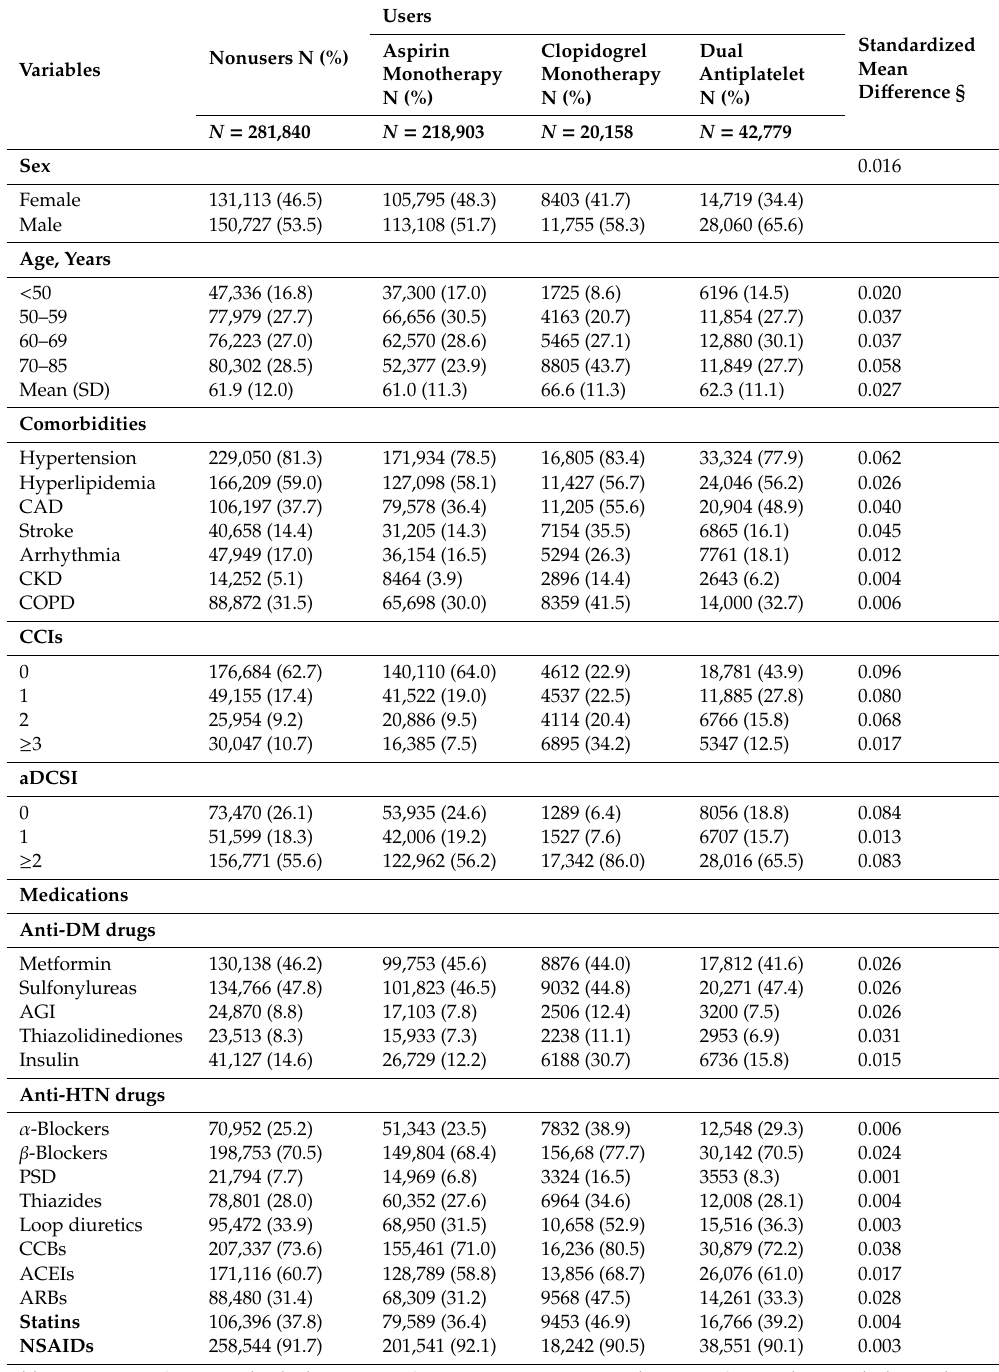
Table 1. Baseline distribution of the demographics and clinical comorbidities in the study cohorts.